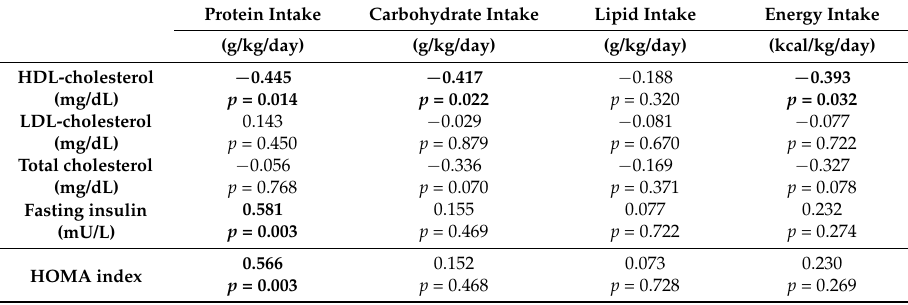
Table 4. Association between early macronutrient and energy intake and metabolic markers in